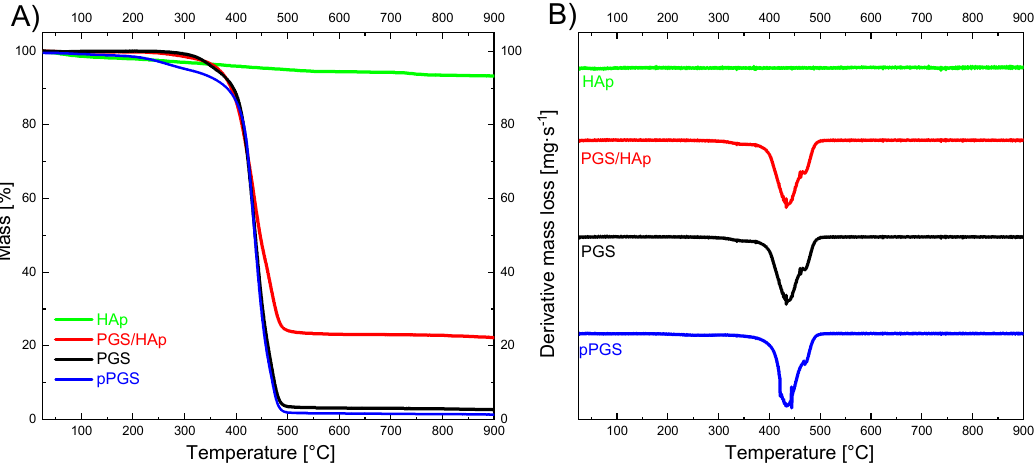
Figure 7. ( A ) Thermogravimetric curves of pPGS and HAp as well as PGS/HAp 75/25 and the PGS porous scaffolds. ( B ) First derivative of the TGA curves of pPGS and HAp as well as PGS/HAp 75/25 and the PGS porous scaffolds. Table 2. Thermal stability set as temperature of 5 wt.%”. loss (T -5% ) and mass loss at 700 °C of hy- droxyapatite, prepolymer and porous scaffolds PGS100 and PGS/HAp 75/25.